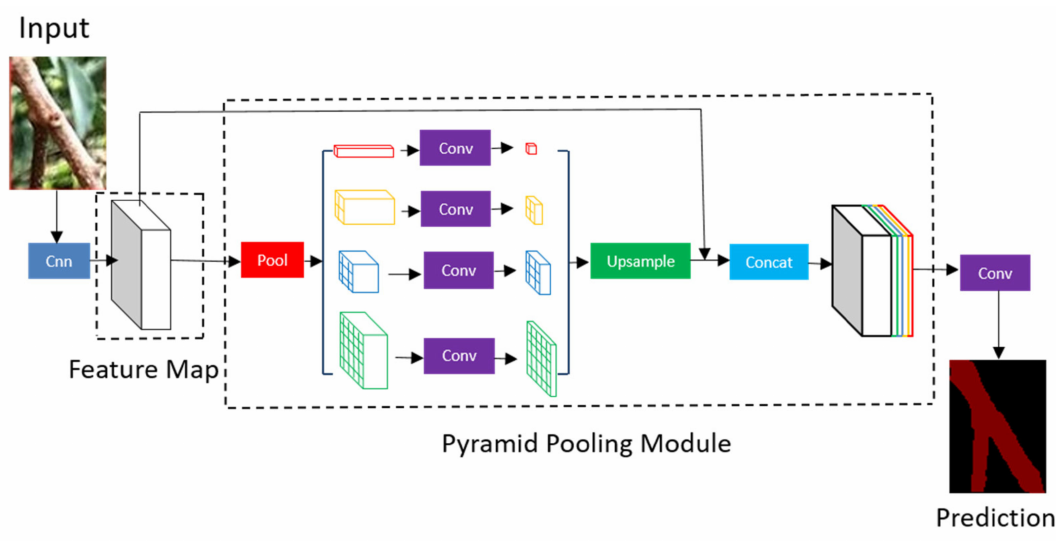
Figure 4. Structure diagram of